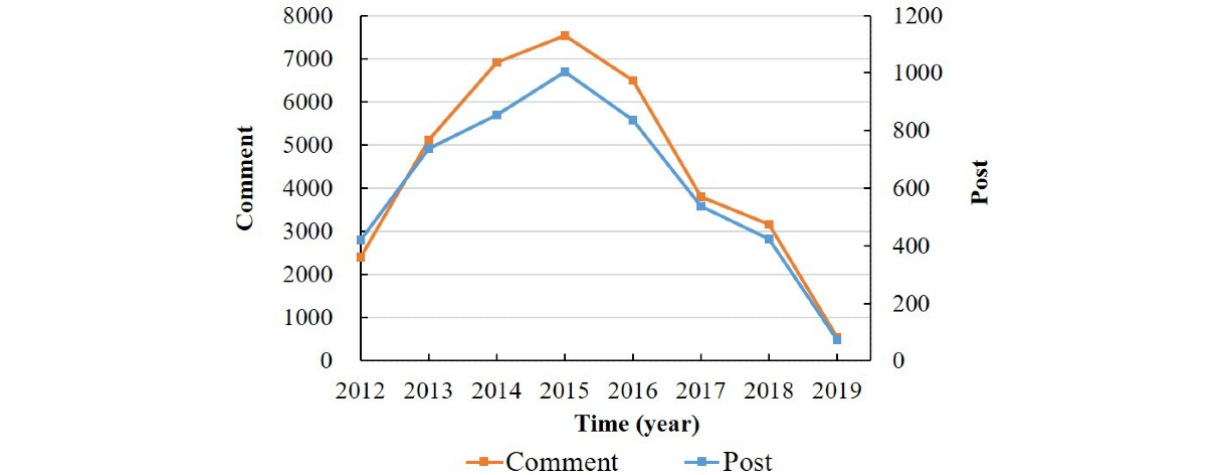
Figure 2. Posts and comments about albinism in the online community in